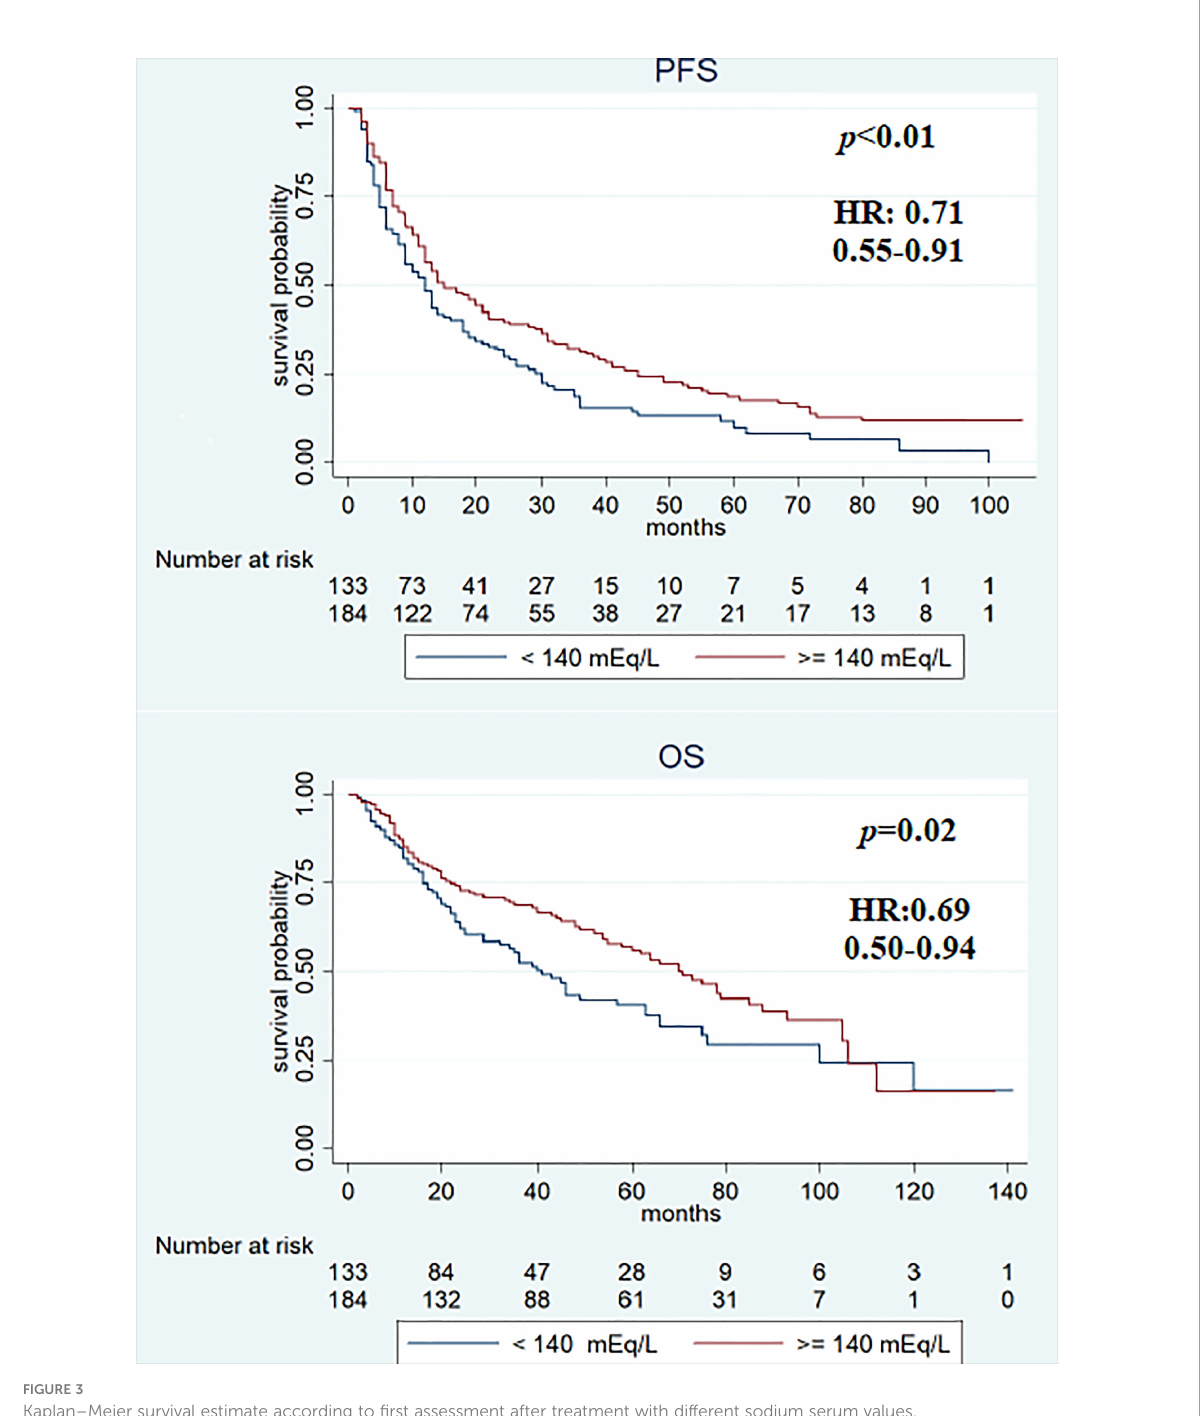
FIGURE 3 Kaplan – Meier survival estimate according to fi rst assessment after treatment with different sodium serum